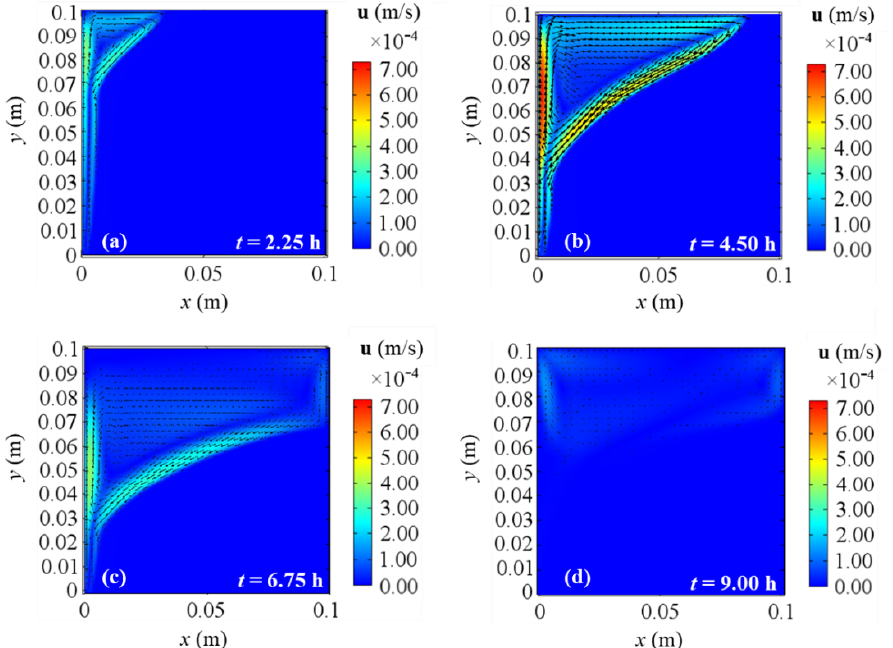
Figure 11. Velocity fields for 2D model with natural convection and BC 2 at different evaluation times: ( a ) after 2.25 h; ( b ) after 4.50 h; ( c ) after 6.75 h; ( d ) after 9.00 h from the simulation beginning respectively.